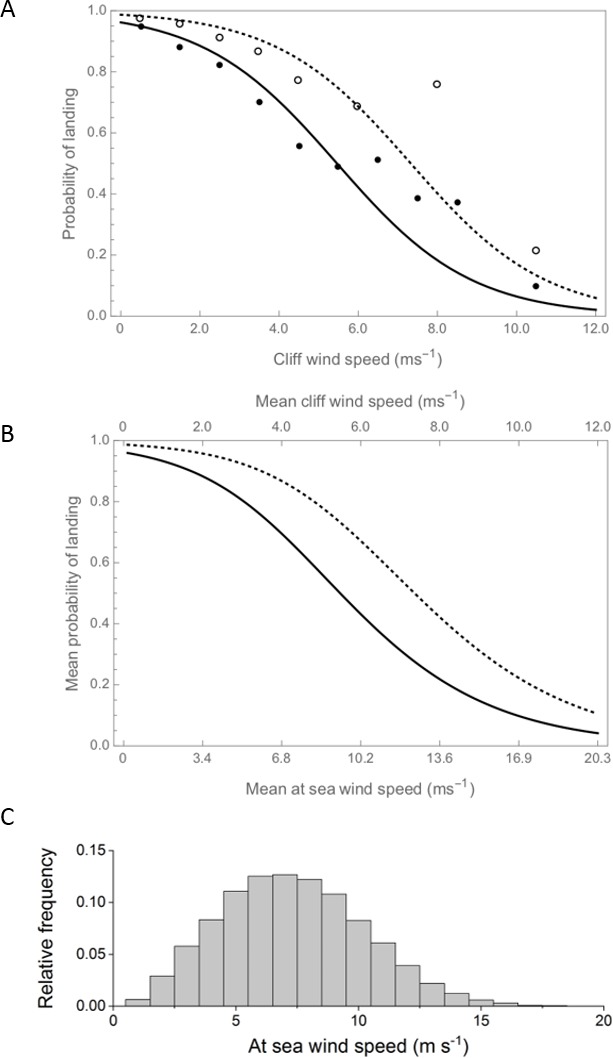
Landing success decreases with increasing wind speed for both guillemots (solid line) and razorbills (dashed line).(A) The probability of landing (derived from the statistical model), declines to ~0.1 in winds of 10 m s−1. Binned raw data are shown for both species (guillemots as filled circles, razorbills as open circles; data are grouped with n ≥ 30 observations per bin). As success also varies with ledge type, both the model output and raw data refer to birds landing on long narrow ledges. (B) The probability of landing according to the mean, at-sea wind speed, as derived from the probabilistic model (also for long narrow ledges and a TI value of 0.2). The difference between the x-axes indicates the increase in wind speed over open water, compared to near the cliffs, as estimated using airflow model outputs averaged across all wind directions. (C) The distribution of at-sea wind speeds across the breeding season (for 2005–2018, recorded at the M5 wave buoy and reduced to 2 m ASL).10.7554/eLife.43842.006Figure 2—source data 2.The raw data on landing observations, along with associated data on species, ledge type and wind speed (see also ‘parameter definitions’).